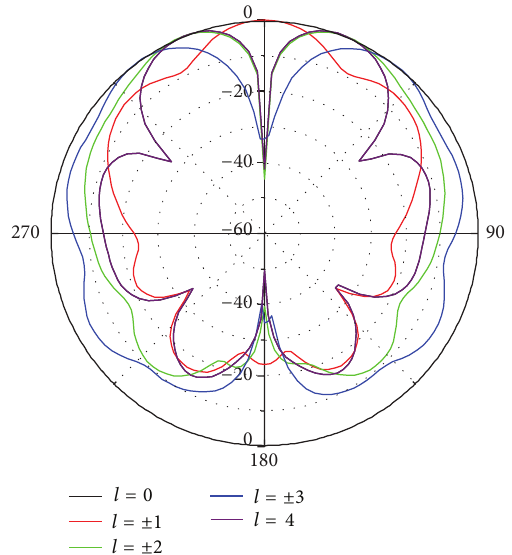
Figure 8: Normalized radiation patterns of the circular array with different OAM states in 𝑥𝑧 -plane at 6 GHz.